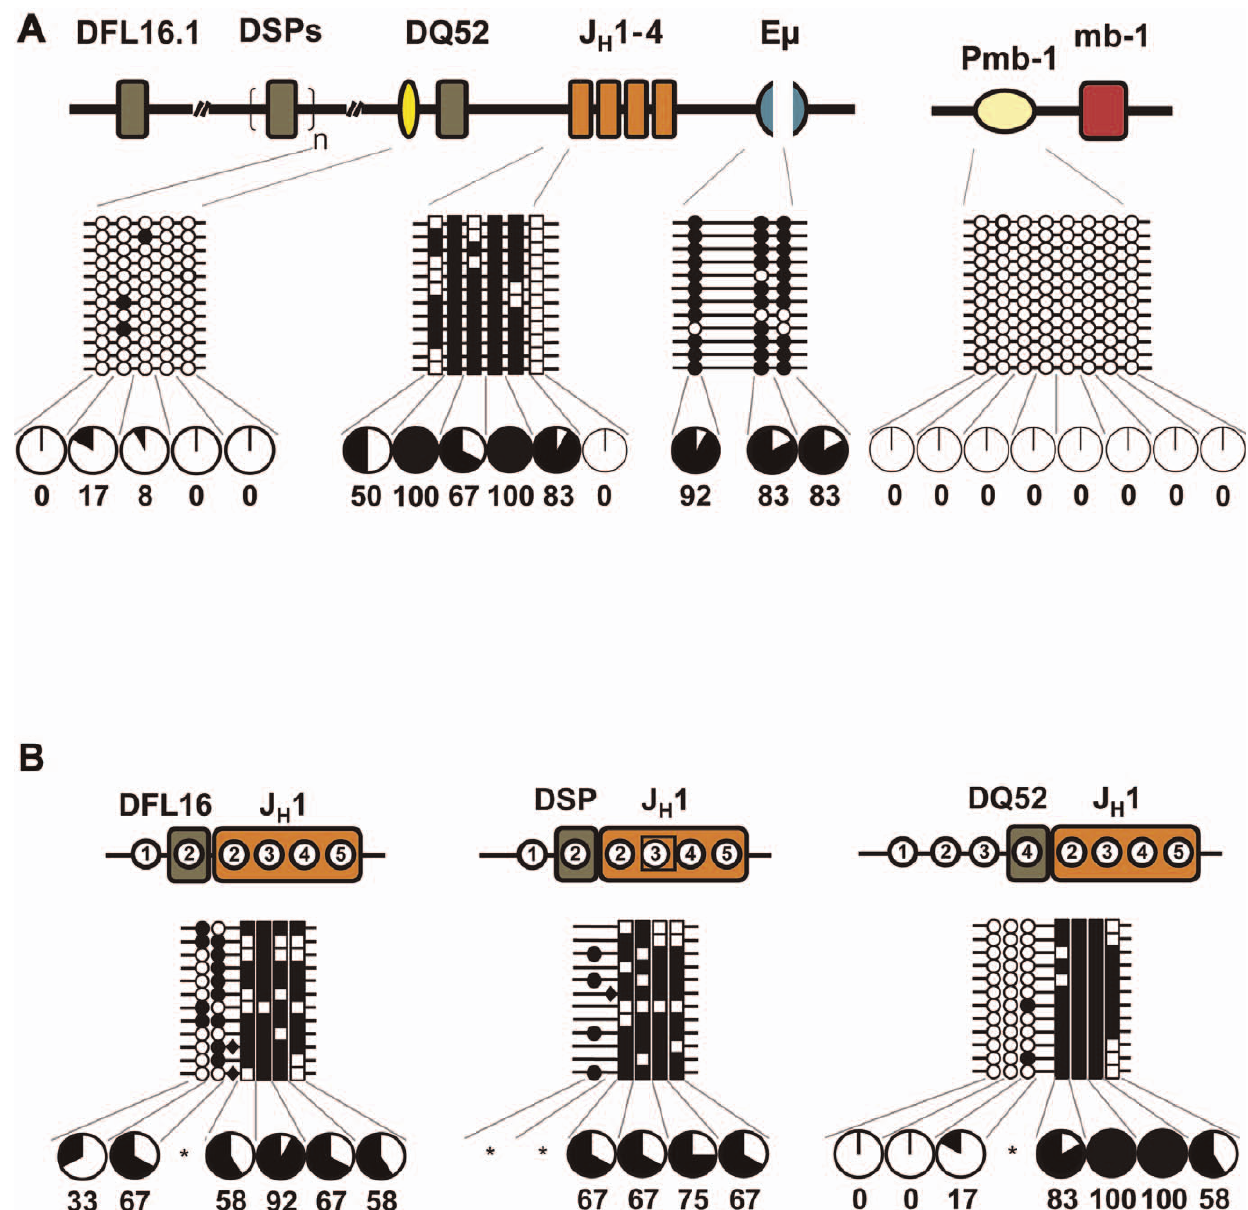
Figure 6. DNA methylation state of IgH alleles in the absence of the intronic enhancer E m . Pro-B cells were purified from the bone marrow of E m -deficient mice [40]. Genomic DNA was subjected to bisulfite modification followed by PCR amplification of germline gene segments (A) and DJ H junctions (B). The 220-bp deletion of E m is represented as partial blue arcs separated by a gap. Filled and open circles, or squares, indicate methylated and unmethylated cytosines, respectively. Numbers within regions marked as DFL16.1, DSP, and J H 1 denote CpG dinucleotides corresponding to the configuration at the respective unrearranged gene segments. For example, of the five CpGs at unrearranged DFL16.1 only the first two are retained in DFL16.1/J H 1 junctions. Three out of five cytosines used to analyze wild-type alleles remain in this deletion, and their methylation status is shown immediately below the disrupted enhancer. Sequences that substitute for the enhancer also contain CpGs whose methylation status is shown in Figure S5. (B) Recombined DFL16.1, DSP and DQ52 to J H 1 junctions were amplified, cloned, and sequenced. Untemplated CpGs incorporated during VDJ recombination were found to be methylated (filled diamonds). Data shown are derived from two independent preparations of pro-B cells from E m -deleted mice, with four to six mice in each experiment.